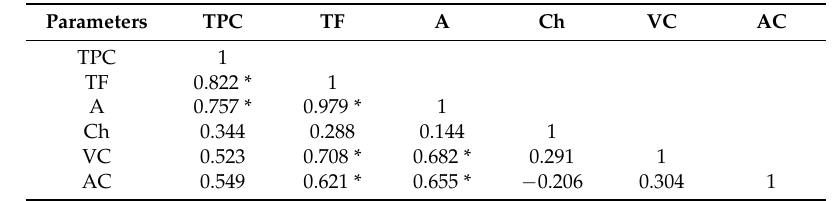
Table 5. Pearson correlation coefficient ( r ) estimated among nutraceutical compounds and antioxidant capacity of hydroponic